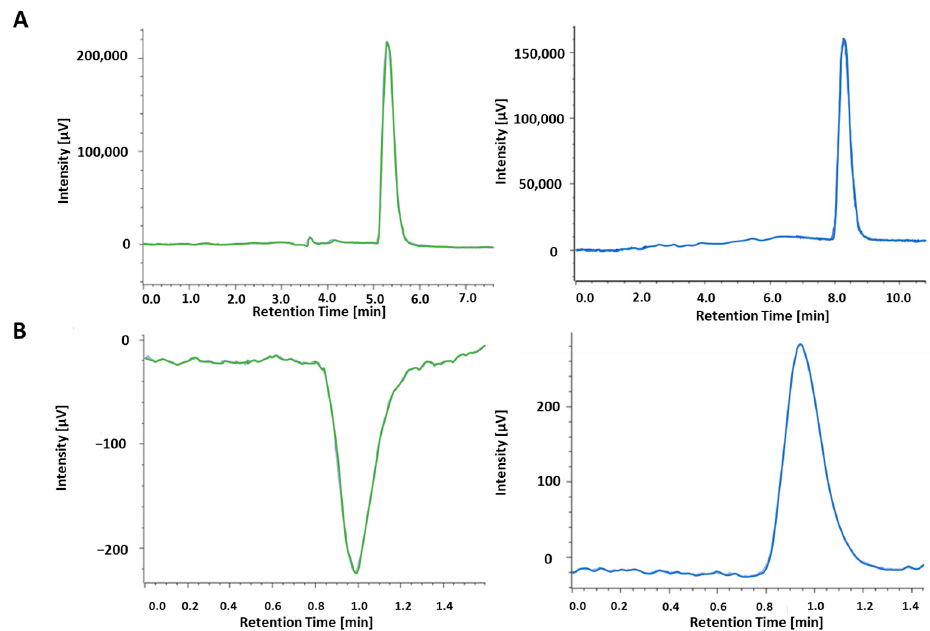
Figure 3. ( A ) UV Chromatographic profile ( λ = 220 nm); Chiralpak IC (4.6 mm I.D. × 250